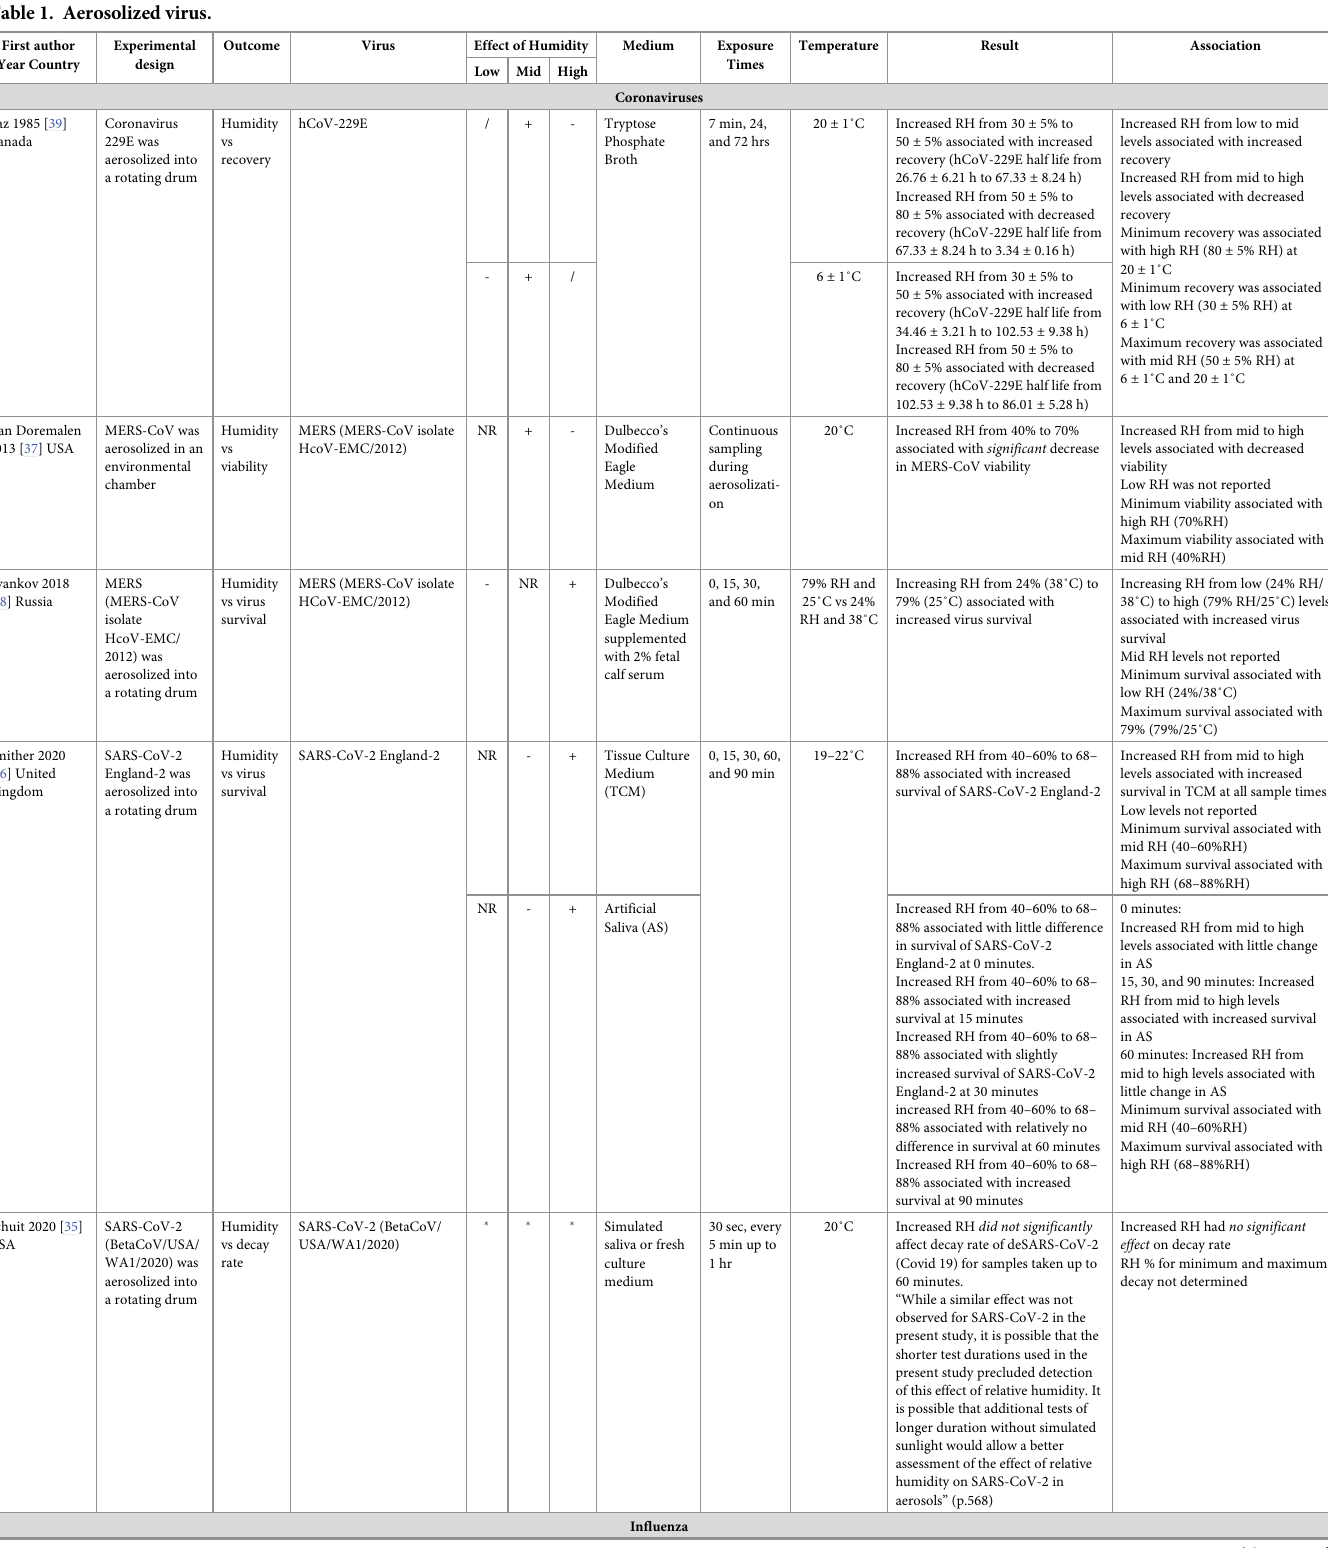
Table 1. Aerosolized